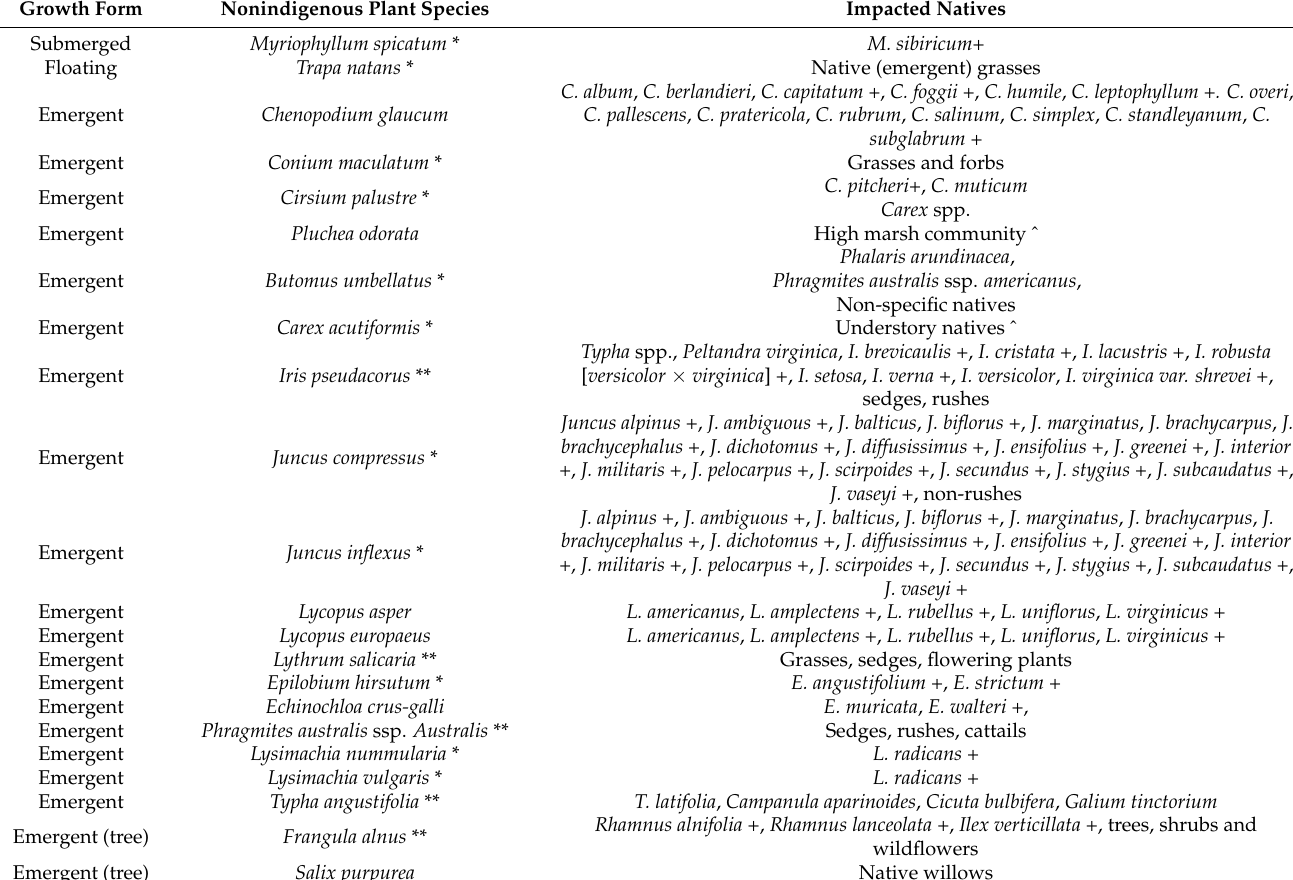
Table 2. Identified pairwise interactions among nonindigenous and impacted native species. Nonindigenous species causing * noticeable stress and ** significant adverse effect; those without a symbol include both those categorized as low and unknown impact (per Figure 3); + at-risk native species; ˆ terms per original source, exact species impacted were not provided in the original source. A high marsh community is defined as the intermittent zone between low marsh and uplands characterized by sandy soil. Understory natives refer to a reported displacement of plant species except for trees/shrubs. sources: